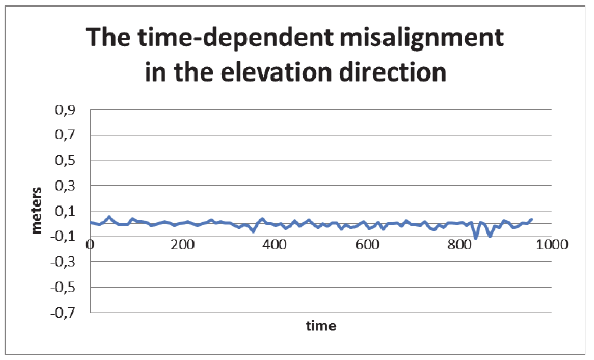
Figure 13. The misalignment of the BLS patch centre points in the elevation direction after the time-based correction.